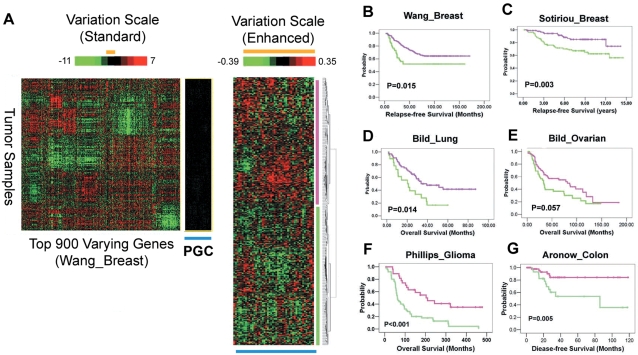
PGC Expression in Primary Tumors Predicts Clinical Outcome.A) Variation in PGC expression in primary breast tumors. (Left) Expression heat-map depicting the range of PGC expression under a normal scale of variation, as assessed by the top 900 varying genes in the Wang_Breast data set (−11 to 7 fold, top scale bar). Under this normal scale, the PGC genes (blue row) are near black and show minimal expression variation across the tumors. (Right) Expression heat-map depicting the range of PGC expression under a magnified scale of variation (−0.39 to 0.35 fold, compare orange bars between the left and right heat-maps). Unsupervised hierarchical clustering was used to segregate the tumors. All subsequent Kaplan-Meier analyses were performed between groups defined by the top level tree branch (purple and green samples). B)–E) Kaplan-Meier survival analysis of patient groups stratified by the PGC expression in primary tumors. Significantly distinct survival outcomes were observed in patients whose tumors express increased PGC levels compared to low-PGC expression patients, in the B) Wang_Breast set (p = 0.015), C) Sotiriou_Breast (p = 0.003), D) Bild_Lung (p = 0.014), and E) Bild_Ovarian cancer cohorts (p = 0.057), F) Phillips_Glioma cancer (p<0.001), and G) Aronow_Colon cancer cohorts (p = 0.005). The outcome metric was relapse-free survival for B), C), and G) and overall survival for D), E) and F).